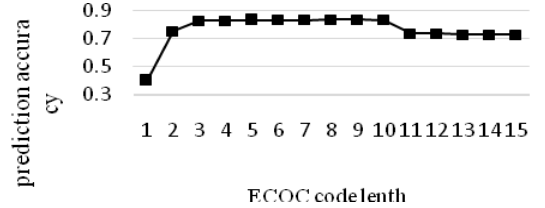
Figure 5. the prediction accuracies corresponding to the forward sequences ECOC